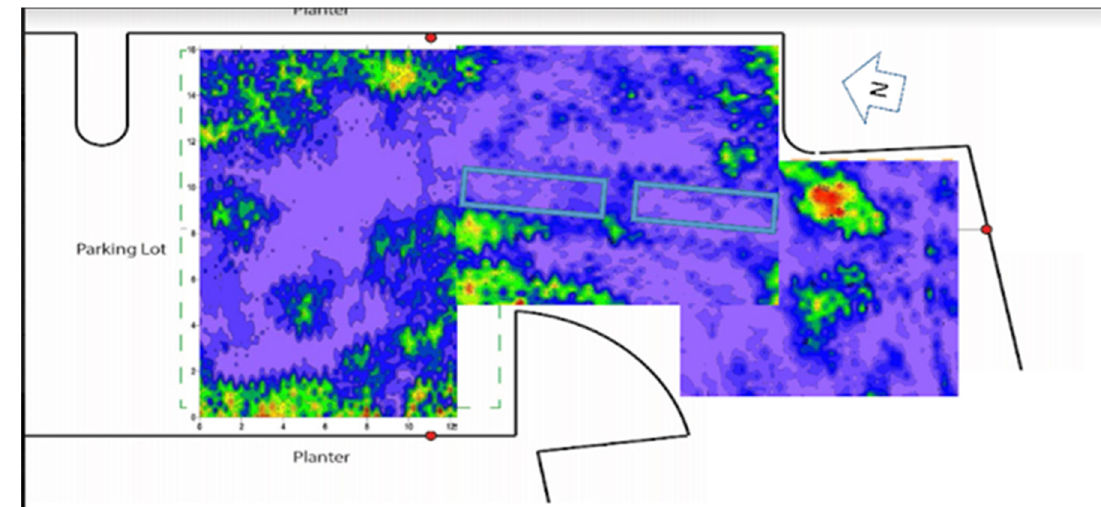
Figure 15. GPR slice map alignment of rectilinear adobe foundation features.